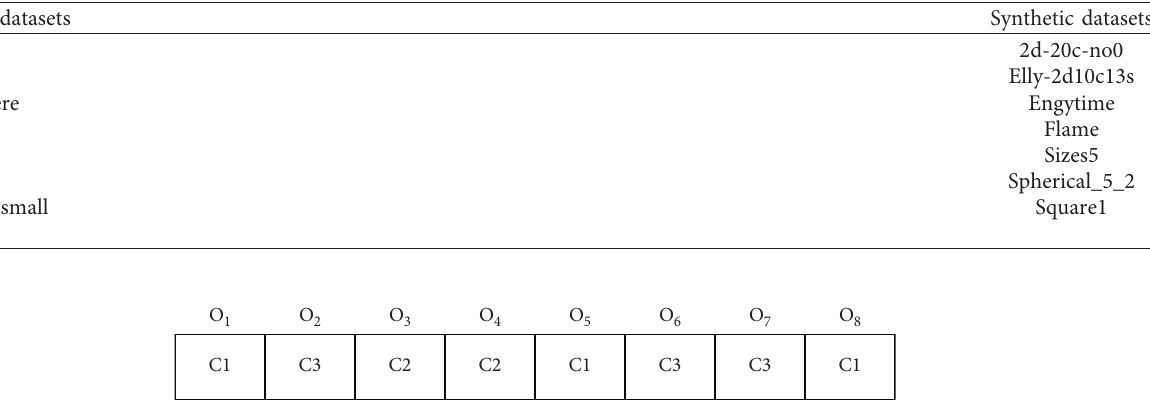
Figure 2: A candidate solution representation example.